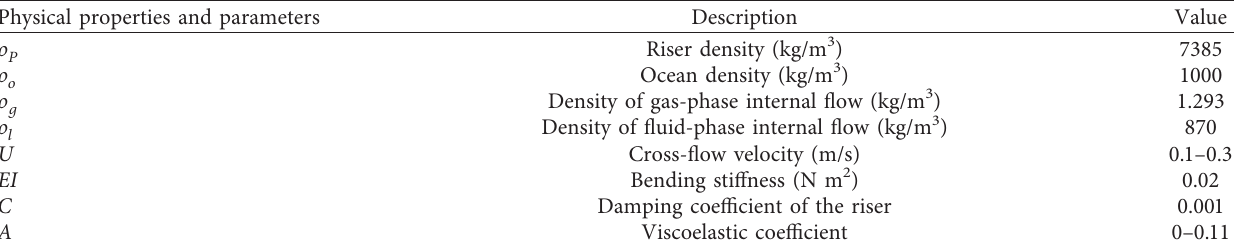
Table 2: Values for physical properties parameters of the marine viscoelastic riser.